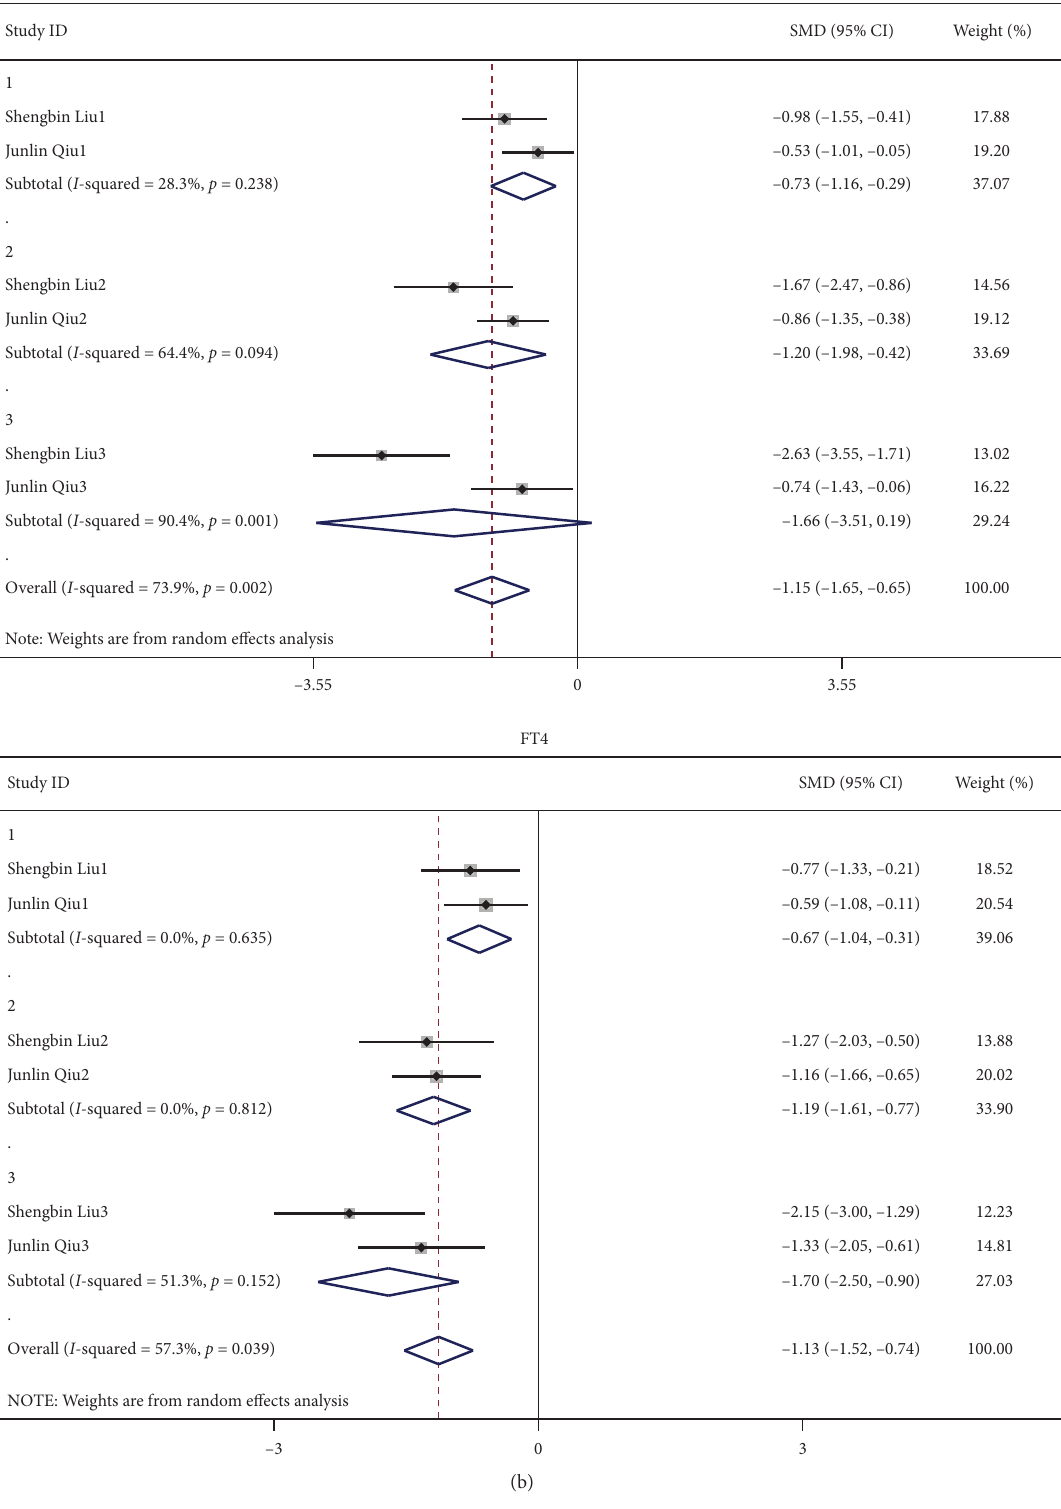
Figure 7: Comparison of severity of DKA and thyroid function in patients with diabetes and